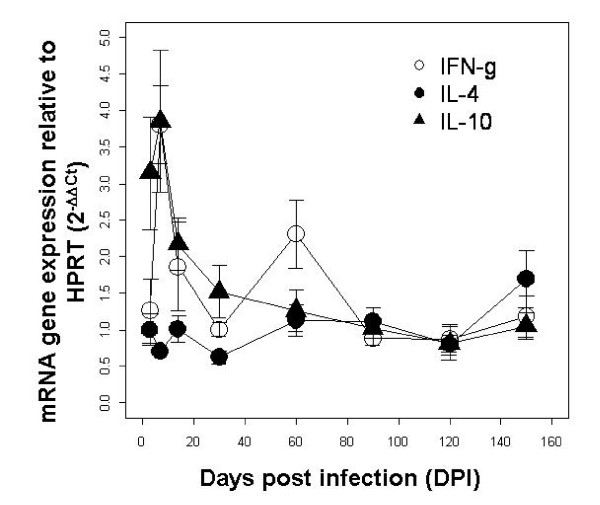
Cytokine gene expression profiles in the lungs at days 3, 7, 14, 30, 60, 90, 120 and 150 post-infection (DPI). Cytokine data are presented using the 2-ΔΔCt ± S.E approach. Briefly, for each rabbit cytokine expression was scaled relative to the housekeeping gene HPRT (Ct), Ct values from infected individuals were then scaled over the controls.